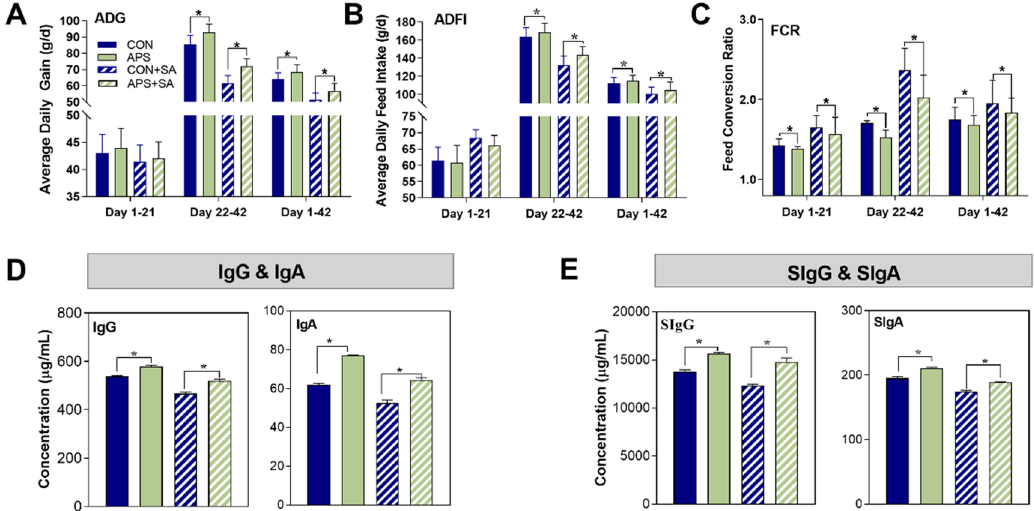
Figure 1. Effects of APS supplementation on growth performance and immune status in pair-fed and S. ser. Enteritidis -challenged broilers. ( A ) Average daily gain (ADG), ( B ) average daily feed intake (ADFI), ( C ) feed conversion ratio (FCR, calculated by ADFI/ADG),) ( D ) IgG and IgA content in serum, and E . SIgG and SIgA content in the duodenal mucosa of broilers. The data are expressed as the mean ± SEM, and an asterisk (*) indicated a significant difference by one-way ANOVA ( p <